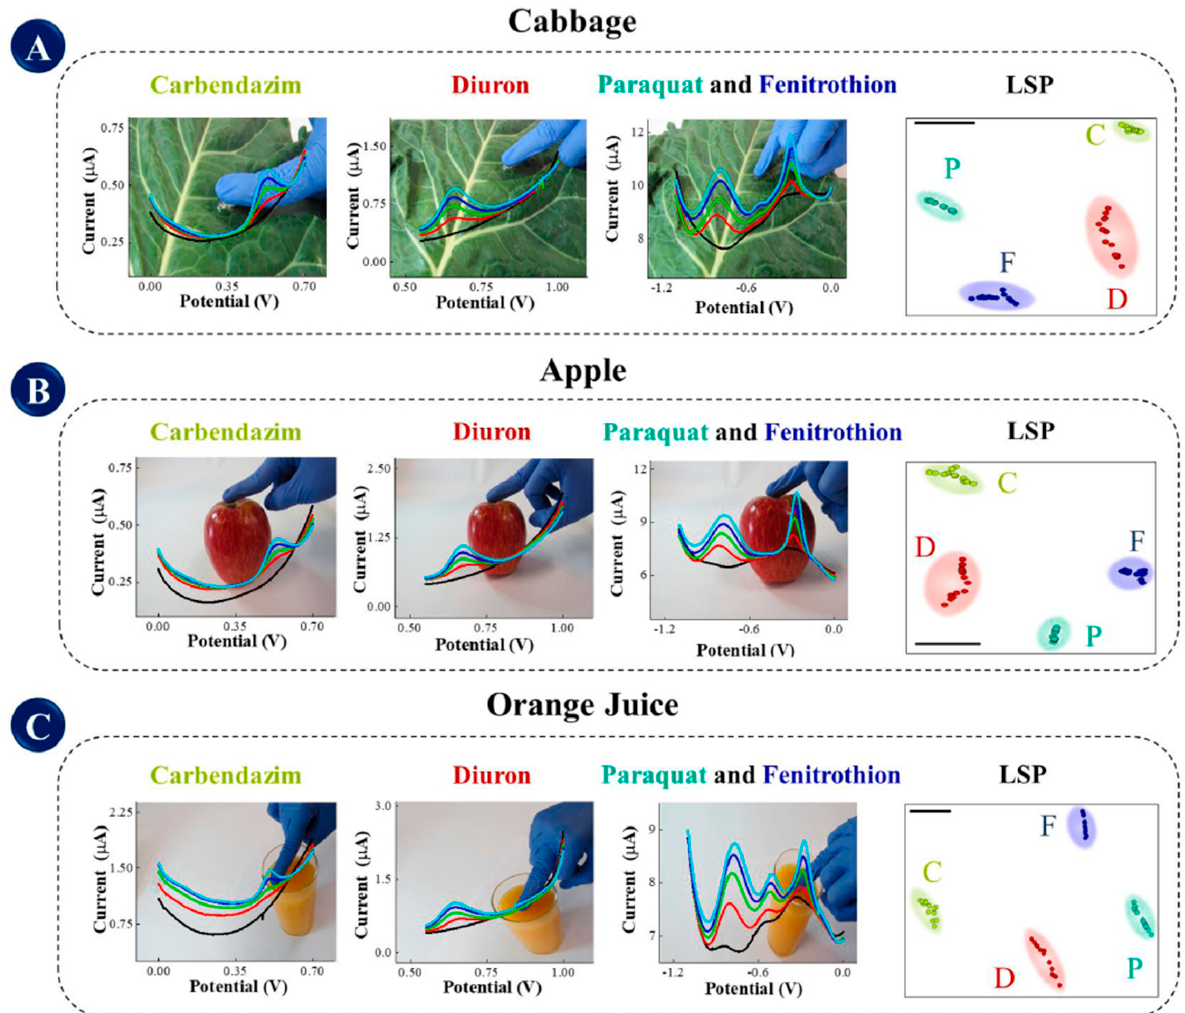
Figure 9. Demonstration of the measurements performed with glove-embedded sensors on real samples of cabbage ( A ), apple ( B ), and orange juice ( C ) for four pesticides, carbendazim, diuron, paraquat, and fenitrothion. Corresponding voltammograms are presented, including the results of simultaneous detection of paraquat and fenitrothion. The least square projection (LSP) plots present the measurements performed with the DPV and SWV techniques, where each coloured dot represents the corresponding voltammogram. Reprinted with permission from Ref. [158]. Copyright